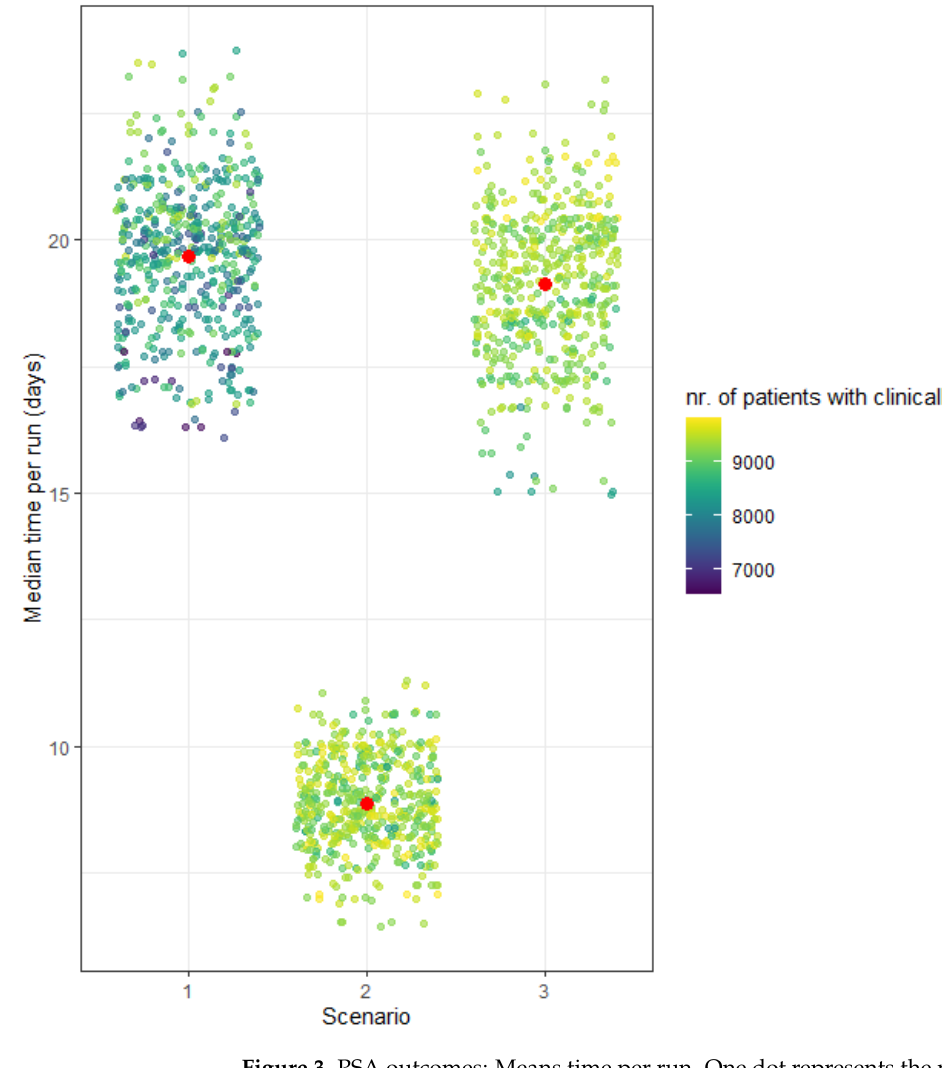
Figure 3. PSA outcomes: Means time per run. One dot represents the median time of one run with 10,000 cases. The higher the number of cases with a clinically relevant result, the lighter the dot. Red = Mean time of all runs. Table 2. Results of the probabilistic sensitivity analysis: mean results of 1000 runs per scenario, presented with 95%